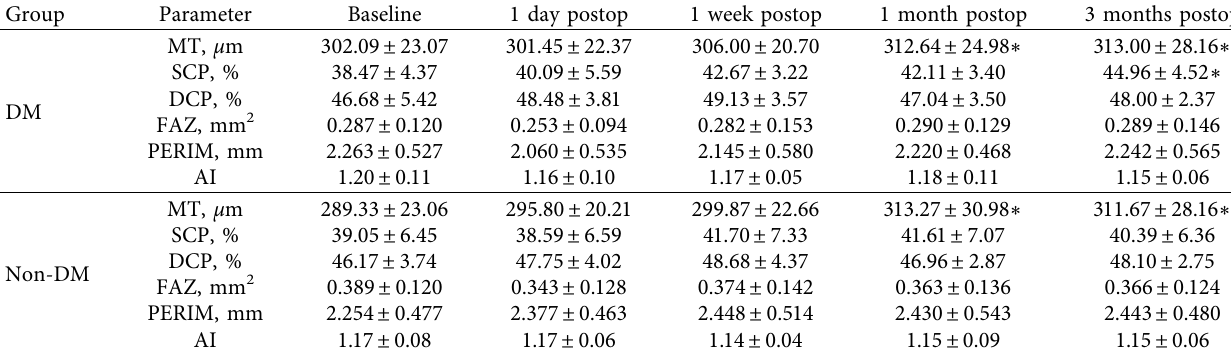
Table 2: Comparison of pre- and postoperative microvasculature